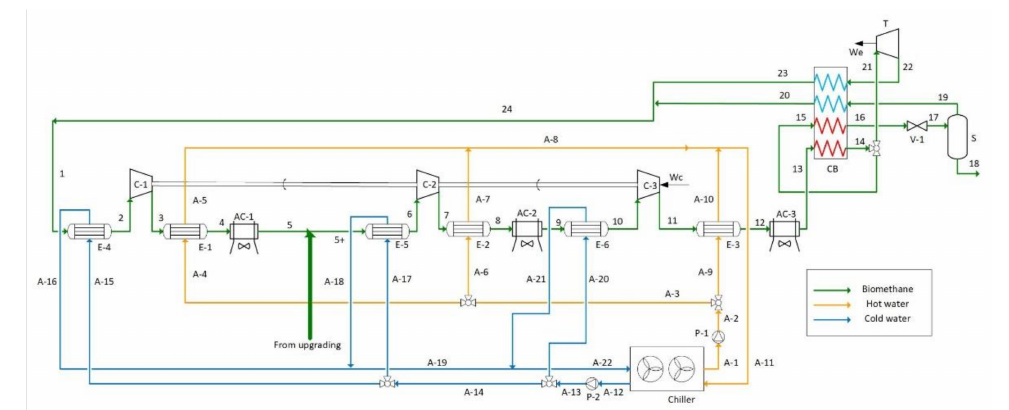
Figure 4. Absorption chiller set-up 1 (AC-1).